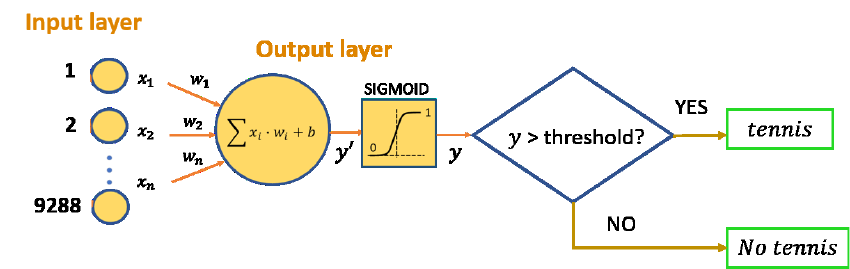
Figure 6. Tennis vs. no-tennis stroke MLP architecture.